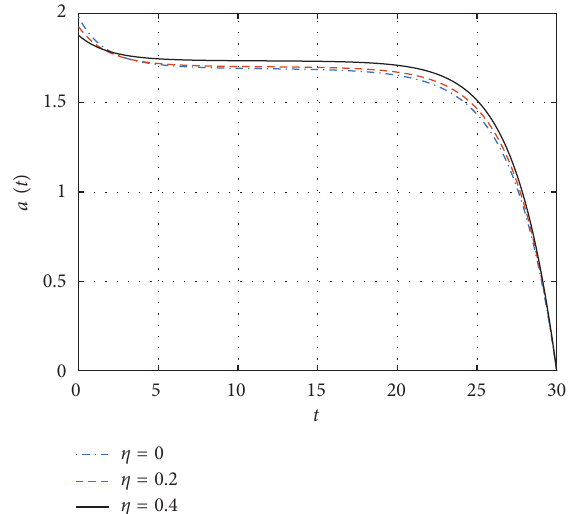
Figure 2: The optimal advertising strategy with different values of parameters η